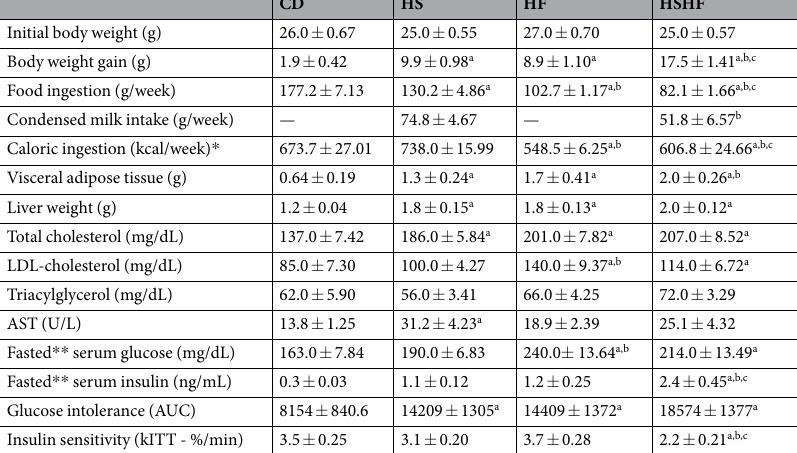
(TGF- β and IL-10) in adipose tissue 6 . Obese patients regularly consume a diet rich in sugar and fat. However, whether fat or sugar has detrimental effects on metabolism remains to be investigated. In this study, we exam- ined the effects of a high-fat diet, a high-sugar diet and a combination of high-fat and high-sugar in the diet on inflammation intensity and insulin resistance in C57BL/6 mice. Mice fed with high-sugar diet had free access to a sweetened condensed milk containing 68% in energy as carbohydrates. Results Three groups of mice were fed obesogenic diets differing in macronutrient composition and total calories. The CD mice served as the baseline. The high quantity of fat in the diet decreased the calorie ingestion by 22% in the